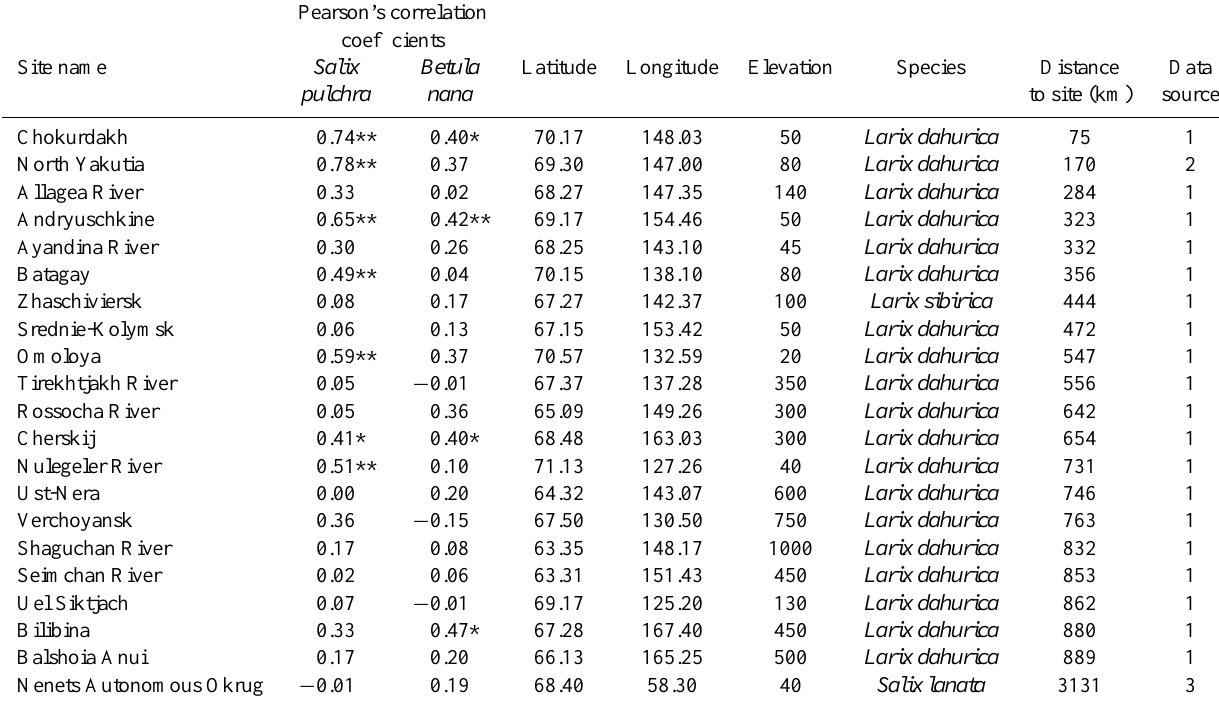
Table 3. Summary of Pearson’s correlation coefficients between the residual chronologies developed in this study ( Salix pulchra and Betula nana ) and 20 residual chronologies developed from tree-ring width data from sites in N-Yakutia, and one residual chronology developed from Salix lanata shrubs from W-Siberia over the common time span 1947–1990.